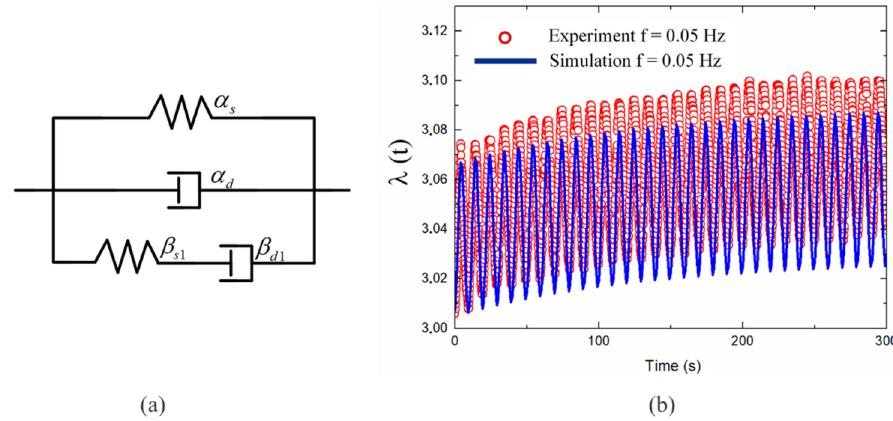
Figure 11. Alternating voltage comparative analysis between experimental results and simulation results for a DE membrane